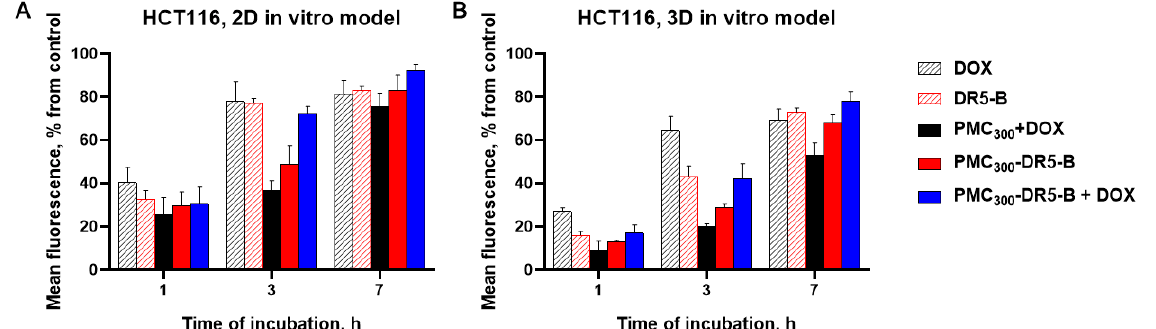
Figure 7. The accumulation efficiency levels of the capsules loaded with DOX (PMC 300 +DOX), modified with DR5-B (PMC 300 -DR5-B), and the capsules loaded with DOX and modified with DR5-B (PMC 300 -DR5-B + DOX) in monolayer cell culture ( A ) and the tumor spheroids from HCT-116 cells ( B ) after 1, 3 and 7 h incubation. Free DOX and free DR5-B were used as controls. The results of flow cytometry ( A ) and fluorimetry ( B